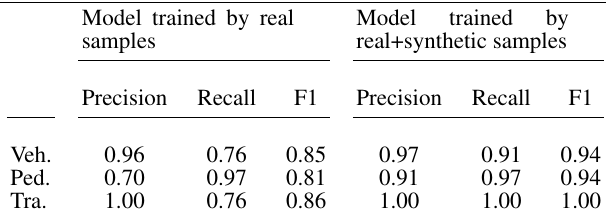
Table 2. Number of real and synthetic training samples